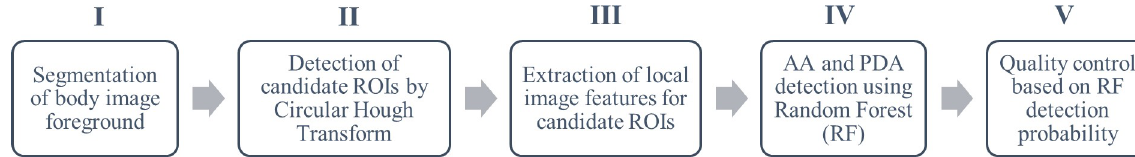
Fig 2. Algorithm flowchart. Automated Ascending and Proximal Descending Aorta (AA and PDA) detection-localization and quality control.